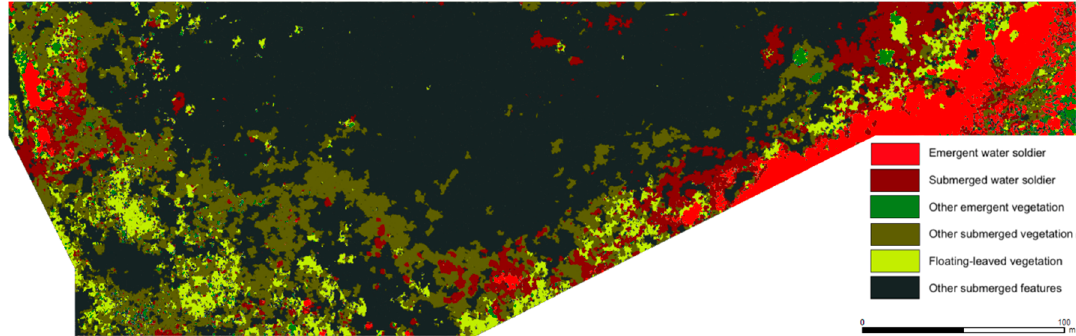
Figure 6. Top classification (above-water and submerged features combined) of study site 2. Table 4. Confusion matrix for the top above-water classification across all five study sites. PA = producer’s accuracy; UA = user’s accuracy; OA = overall accuracy.